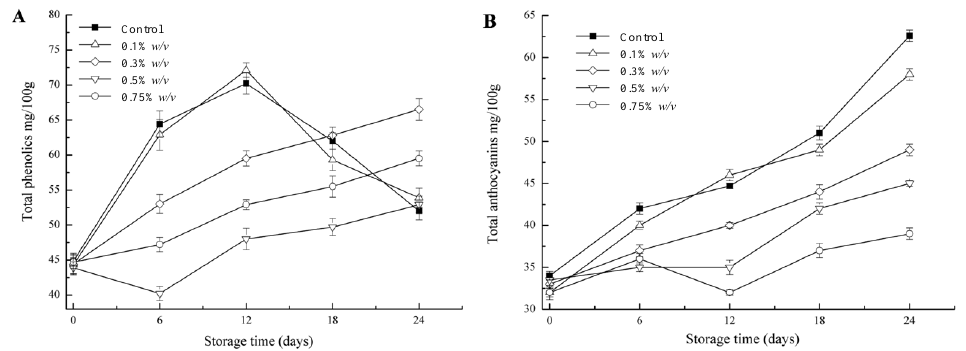
Figure 3. Change of total phenolic contents ( A ), total anthocyanin contents ( B ) in sweet cherry stored at 10 °C during storage time. The data are the means ± standard-deviation (SD).